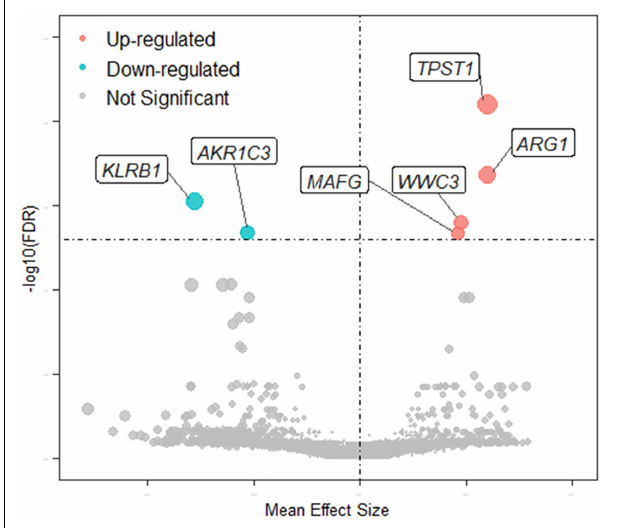
FIGURE 2 | Volcano plot of MDD-related DEGs. Node colors define change direction in DEGs: red for upregulated genes, green for downregulated genes, and gray for not significant genes. Node size combines the effect size and FDR value: a larger node indicates that mean effect size of gene is large and FDR value is